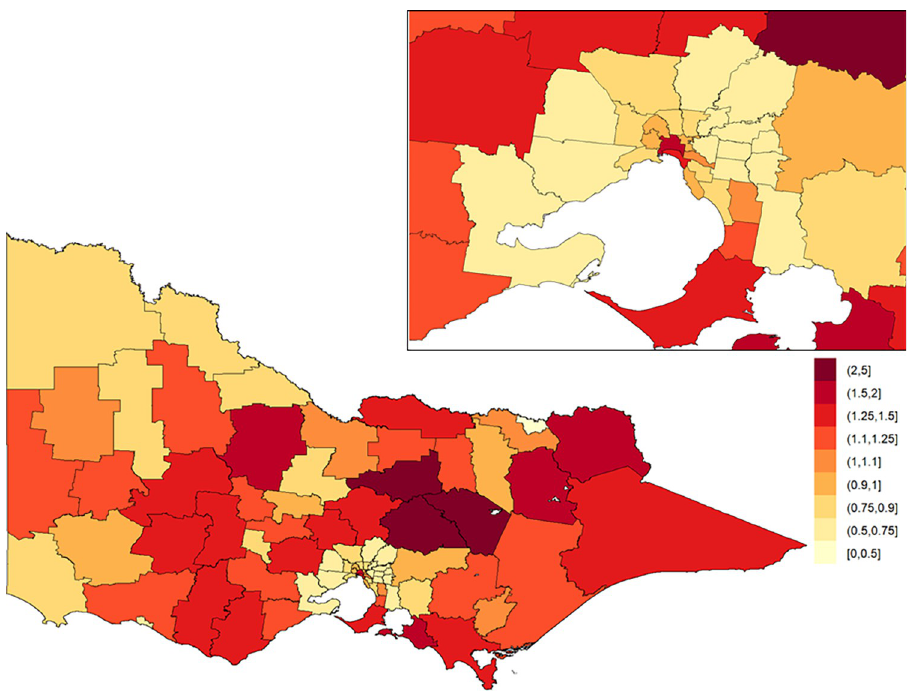
Fig 3. Posterior mean of the area-specific relative risk for major trauma overall in Victoria. Here, a value of one indicates that the area-specific risk (averaged over time) is the same as that in the whole of Victoria, a value less than one indicates that it is lower than that in the whole of Victoria, and a value greater than one indicates that it is higher than that in the whole of Victoria. The inset on the top-right shows Greater